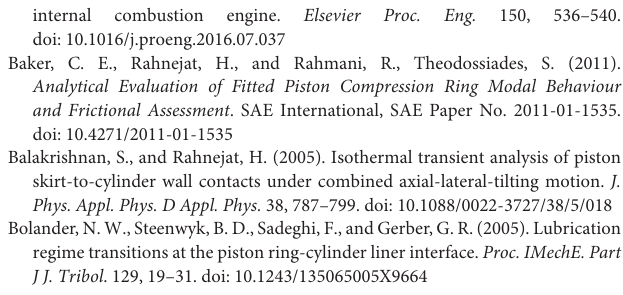
presents the cyclic variation of velocity ( Figure 13A ), lubricant pressure ( Figure 13B ), and viscosity ( Figure 13C ) in an engine cycle. The viscosity shows a soaring high value in high pressure zone of compression and power stroke transition. Though there should be decrease in viscosity due to increase in temperature, but simultaneously there is increase in lubricant pressure. The net effect leads to increase in